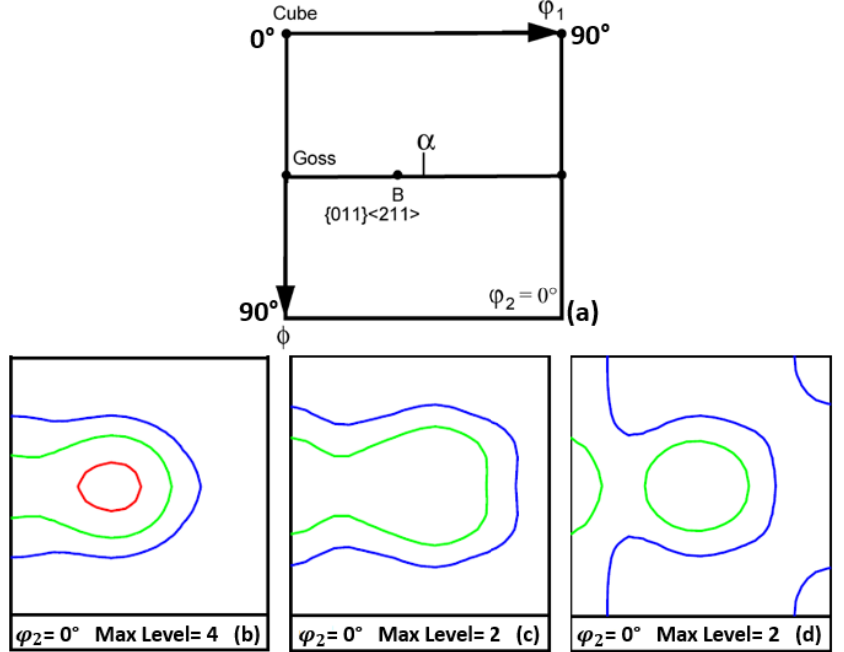
Figure 11. ( a ) Orientation distribution function section with select fibers and orientations in FCC metals. Austenite textures of superduplex stainless steel are presented in the same section for the ( b ) industrial, ( c ) ultrafine and ( d ) equiaxed microstructures.